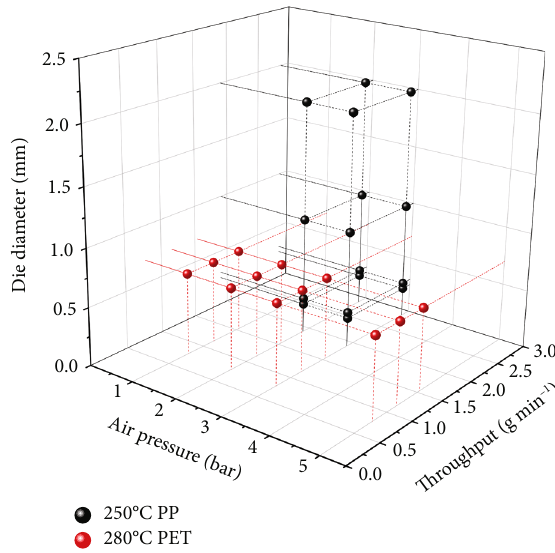
Figure 3: Schematic representation of the process parameters utilised during melt spinning on the pilot